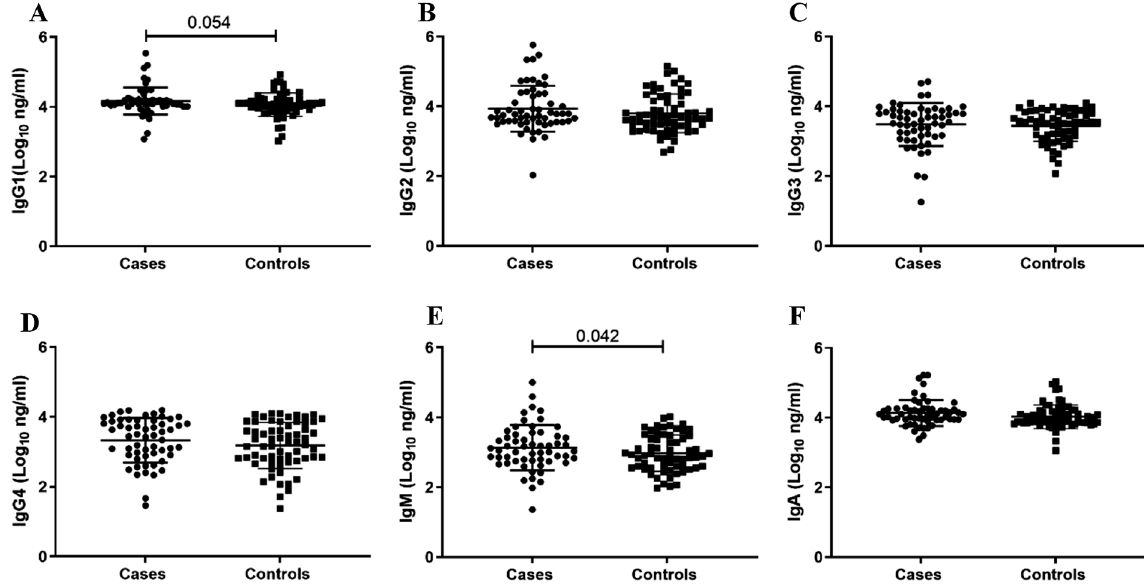
Figure 1. Comparison of mucosal immunoglobulin IgG subclasses and isotypes (Log 10 ng/ml) between matched controls and cases pre-HIV infection. Each data point represents an individual sample. Cases represent women who subsequently became HIV-infected, and controls represent women who remained HIV-uninfected. The scatter dot plot includes the medians and interquartile ranges. Wilcoxon signed rank test and paired t-tests were used to compare between the case-matched-control groups and p < 0.05 were considered statistically